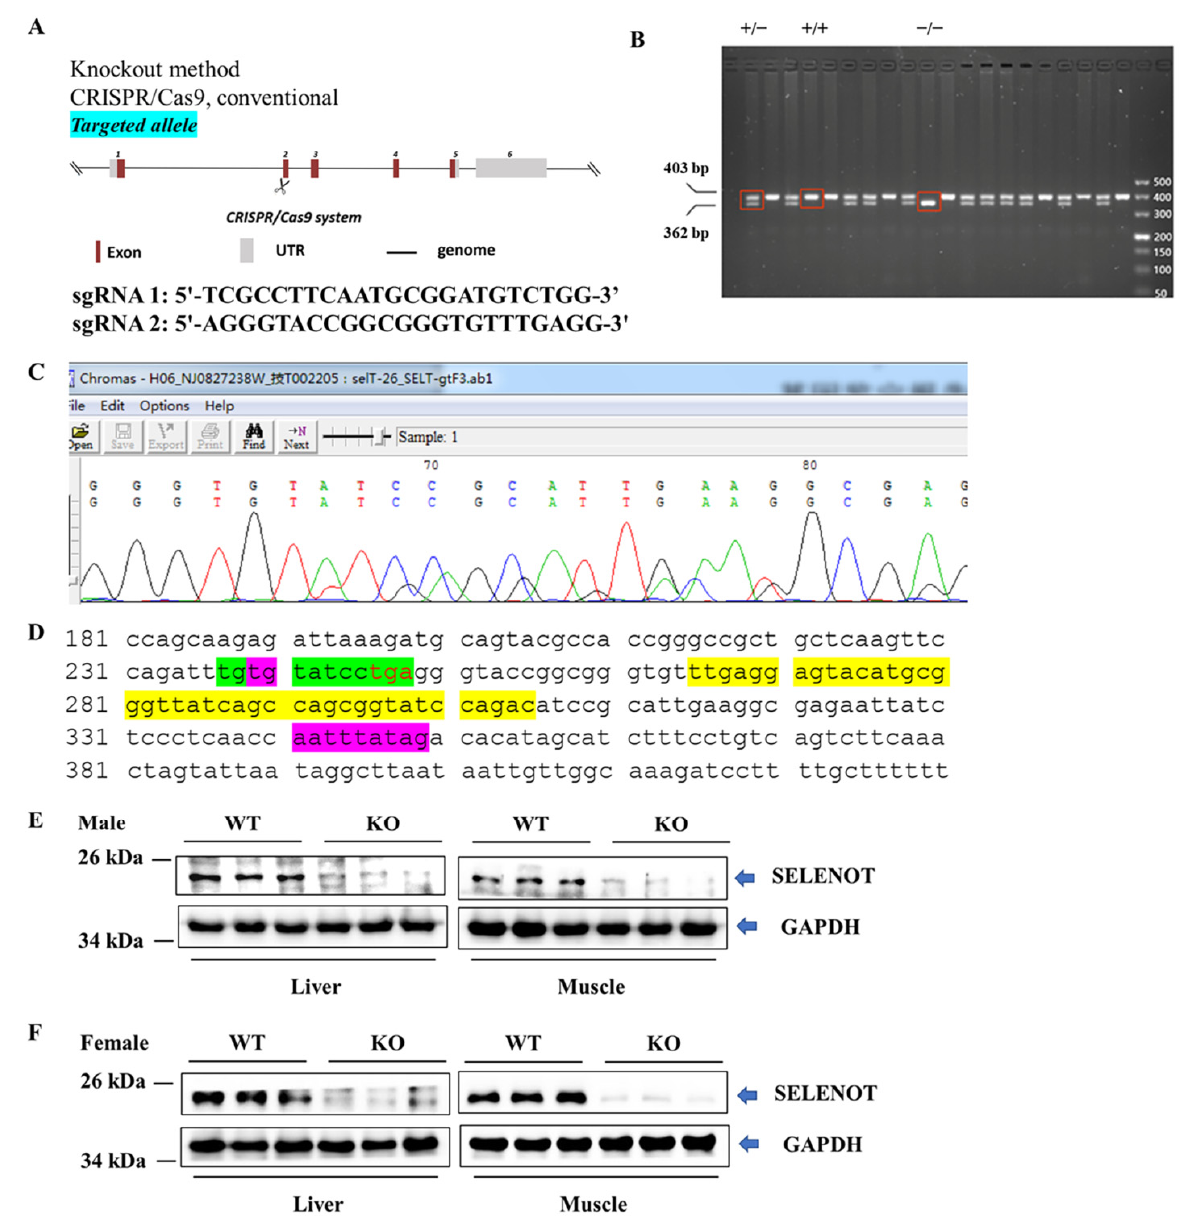
Figure 1. Establishment and identification of global Selenot -KO mice. ( A ) Global Selenot -KO mice were established via the CRISPR/Cas9 system, where dual sgRNA recognition sites were located on exon 2 of Selenot . ( B ) The agarose gel electrophoresis image of the PCR products of Selenot from the WT (+/+), heterozygote (+/ − ) and KO ( − / − ) mice. ( C ) Gene sequencing result for smaller bands in the PCR products of Selenot from heterozygous mice (Delete 41 bp on exon 2, resulting in frameshift GGTACCGGCGGGTGT-----------------------------------------ATCCGCATTGAA). ( D ) Partial gene sequence of Selenot . The gene sequence between the green highlighted parts corresponds to the active center of SELENOT, and the gene sequence between the purple highlighted parts is exon 2, and the yellow highlighted sequences are knocked out. ( E ) SELENOT protein content in liver and skeletal muscle from the male WT (+/+) and KO ( − / − ) mice detected by western blot ( n = 3). ( F ) SELENOT protein content in liver and skeletal muscle from the female WT (+/+) and KO ( − / − ) mice detected by western blot ( n = 6).